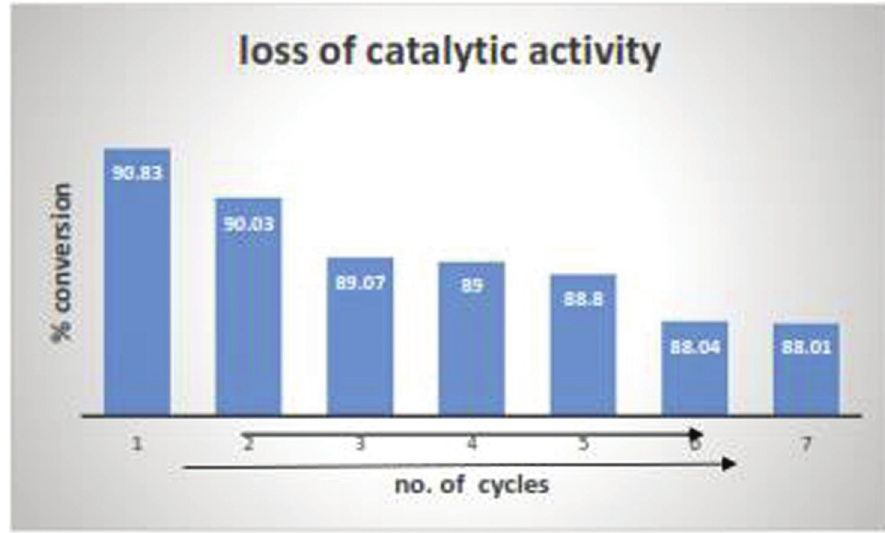
Figure 15: The loss of the catalytic activity of PdNPs on repeated cycle.